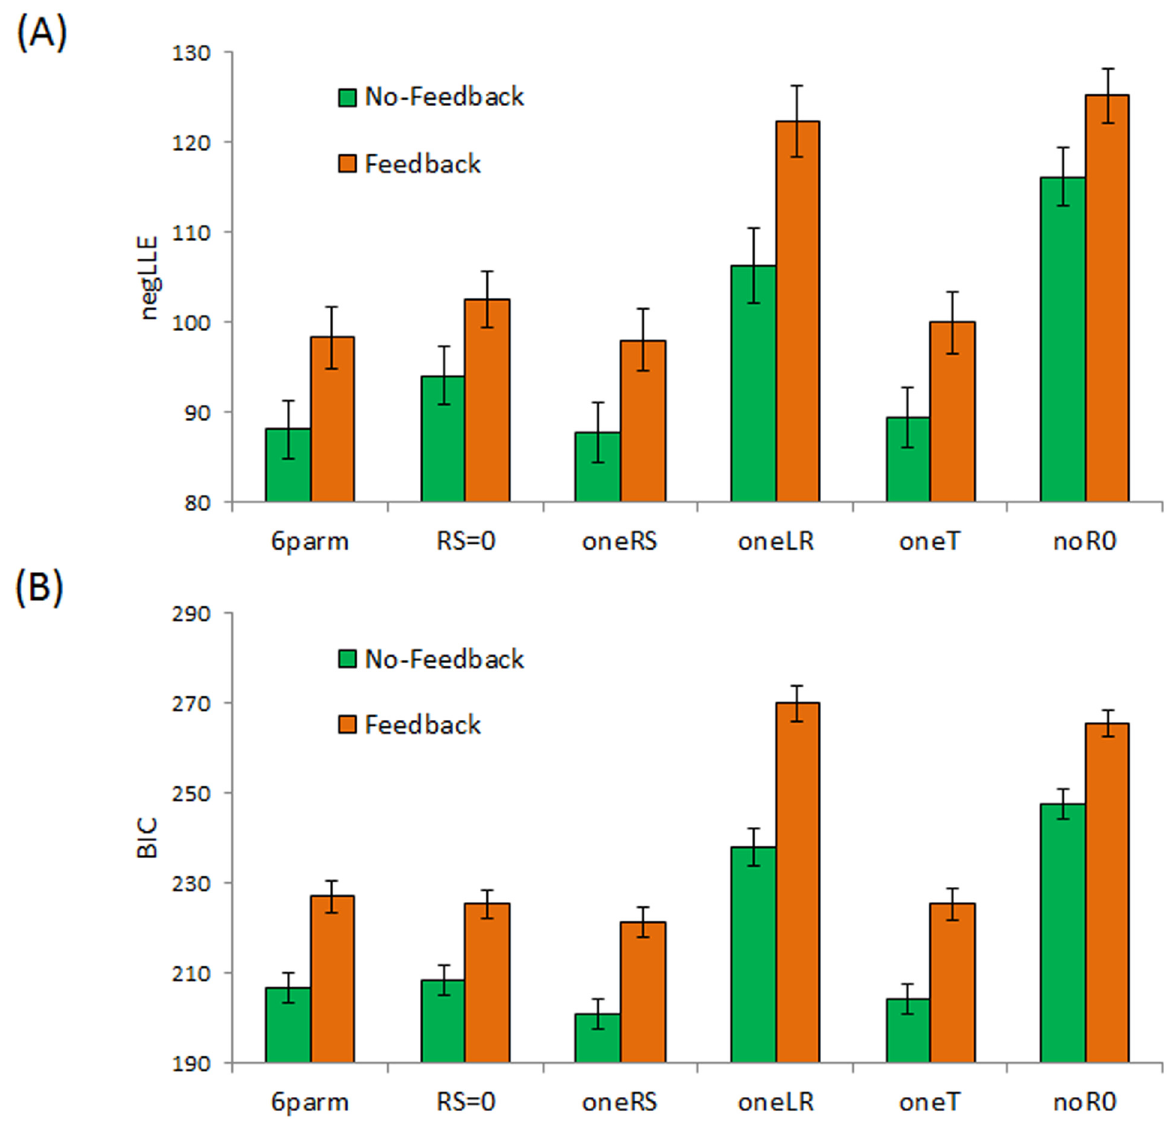
Fig 4. Model fit in terms of (A) negLLE and (B) BIC for the six models from Table 1, applied to data from subjects in the no-feedback and feedback